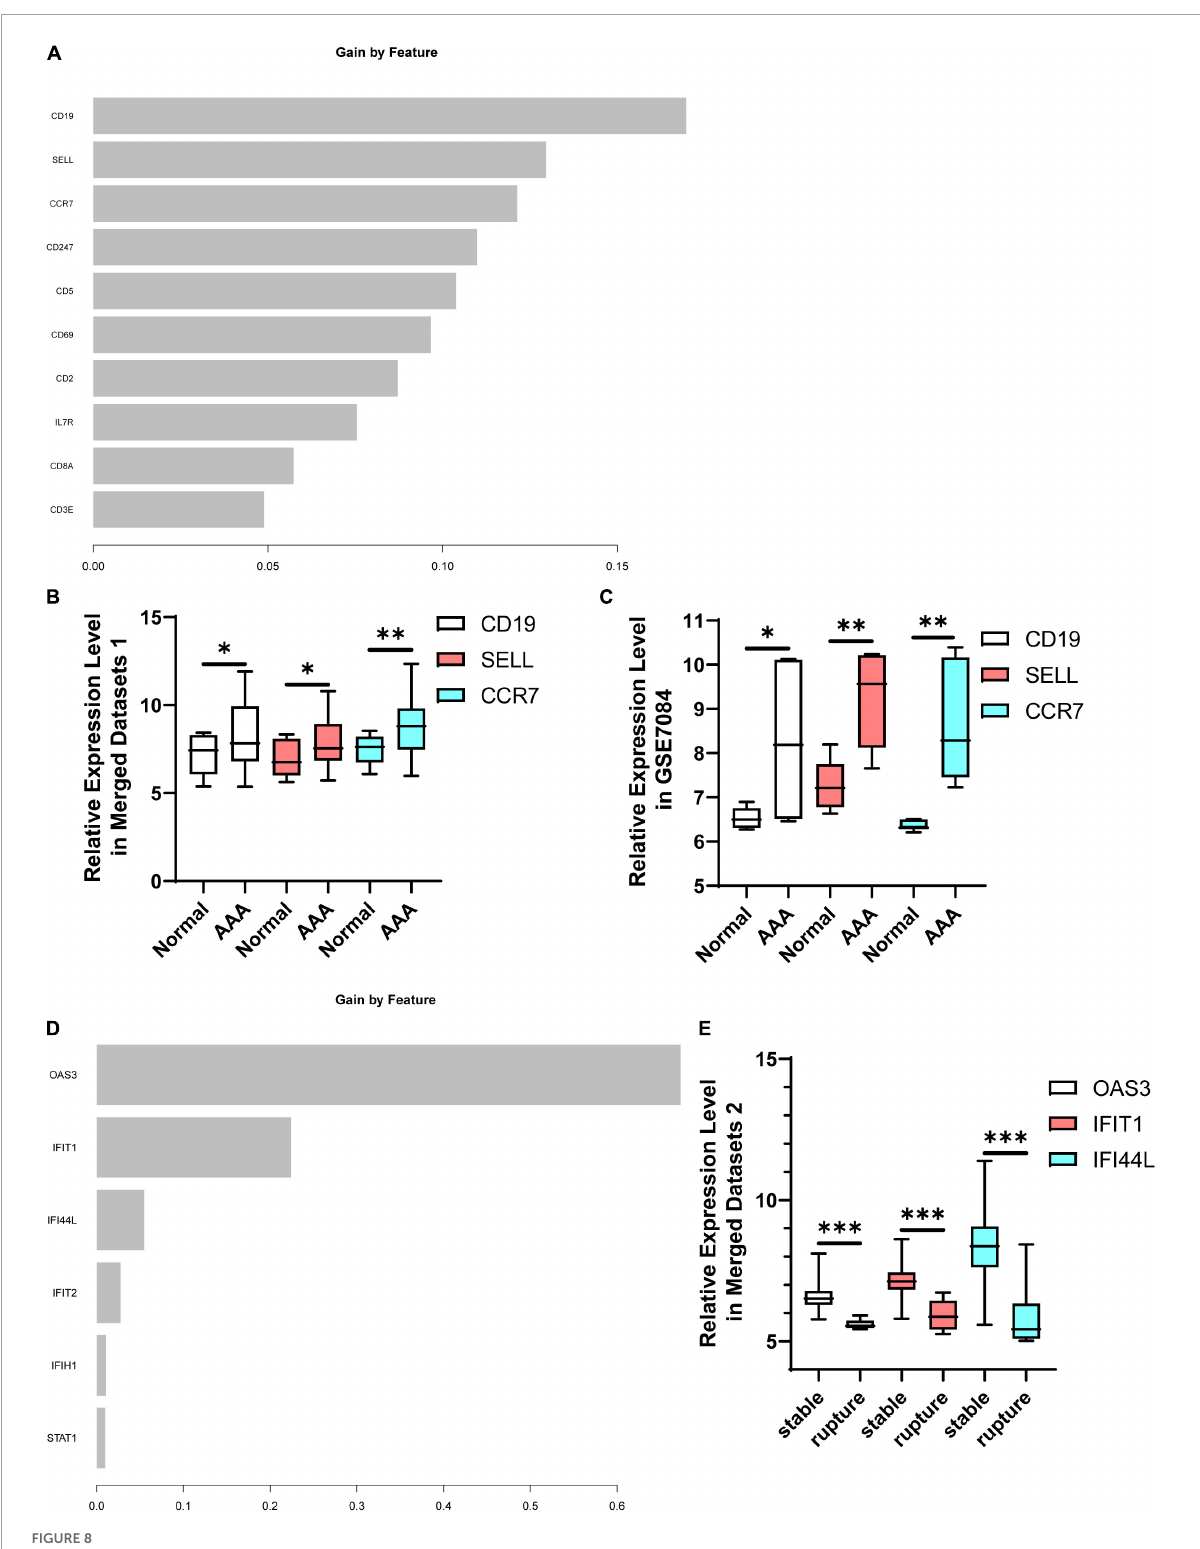
FIGURE8 Identification of hub genes. (A) The rank of feature importance in AAA predictive model. (B) The expression levels of CD19, SELL, and CCR7 in AAA-related merged dataset 1. (C) The expression levels of CD19, SELL, and CCR7 in testing set GSE7084. (D) The rank of feature importance in aortic rupture predictive model. (E) The expression levels of OAS3, IFIT1, and IFI44L in aortic rupture-related merged dataset 2. AAA, abdominal aortic aneurysm. * p < 0.05, ** p < 0.01, *** p <